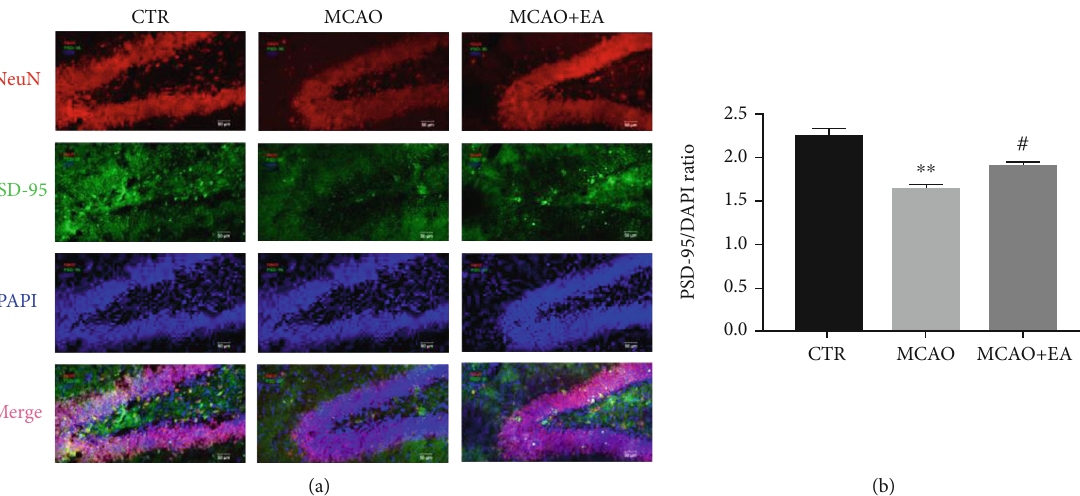
Figure 9: E ff ects of MCAO and EA on the fl uorescence intensity ratio of PSD-95/DAPI in the hippocampus. The fl uorescence intensity ratio of PSD-95/DAPI (b) was analyzed. Data are expressed as mean ± SEM , where ∗∗ p < 0 : 01 compared to the control group and # p < 0 : 05 compared to the MCAO group ( n = 3 each group). CTR: control; MCAO: middle cerebral artery occlusion; EA: